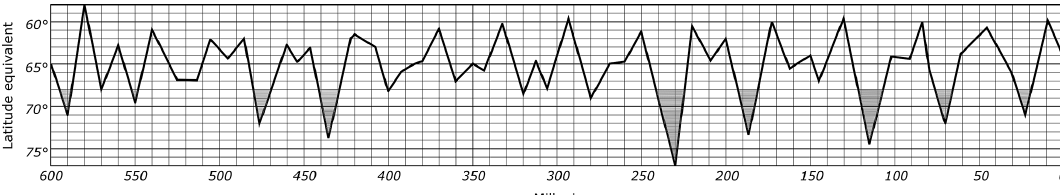
Figure 6. The equivalent graph which shows the variations of the summer insolation for 65 ◦ N. Reprinted from Kanon der Erdbestrahlung und seine Anwendung auf das Eiszeitenproblem (p. 415) by Milankovitch (1941), Royal Serbian Academy Special Publications.